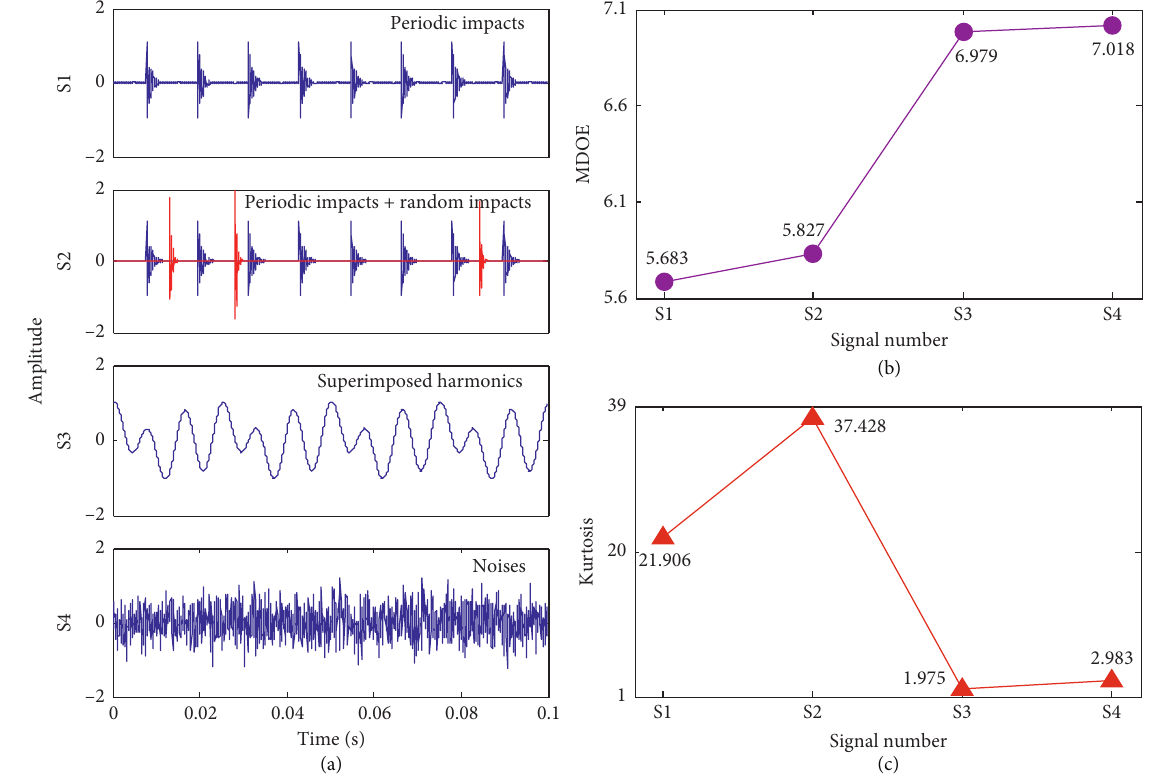
Figure 3: (a) The waveforms of four different simulated signals. (b) The corresponding MDOE indicators. (c) The corresponding kurtosis indicators.